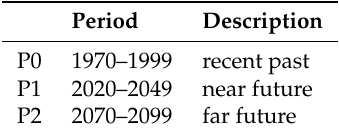
Table 2. Definition of climatological periods, P0 (recent past), P1 (near future), and P2 (far